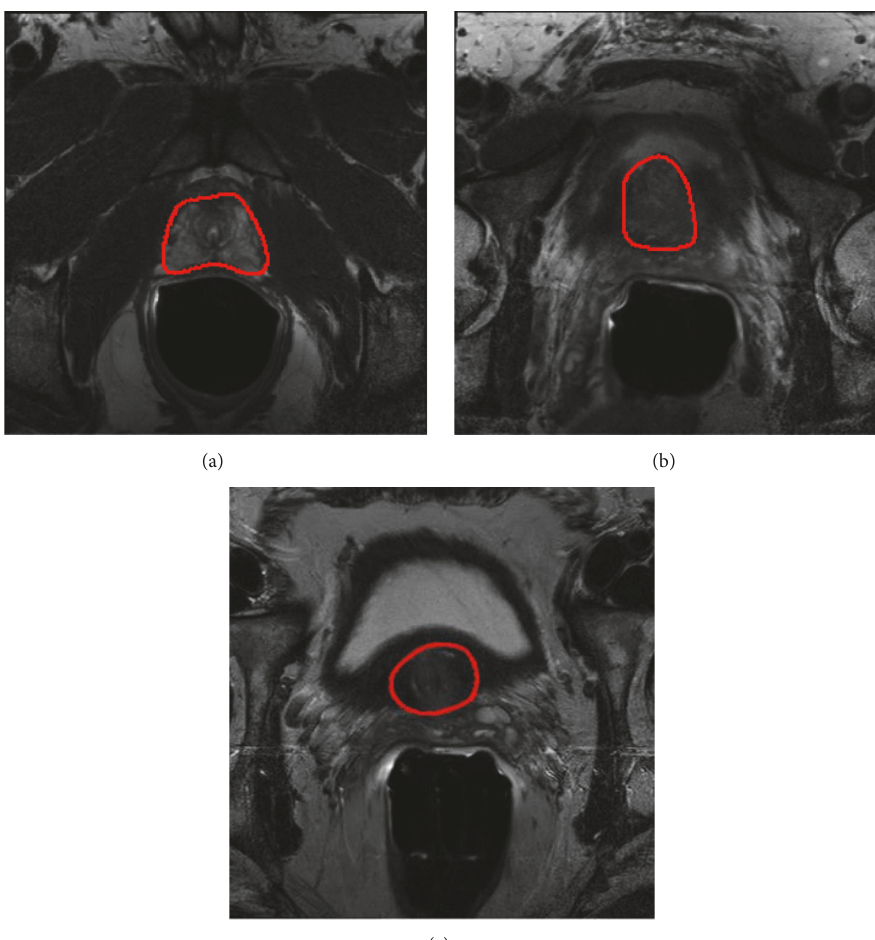
Figure 1: Challenges in segmenting prostate in MR images. (a) Imaging artifacts inside the bladder. (b) Weak boundary. (c) Complex intensity distribution.